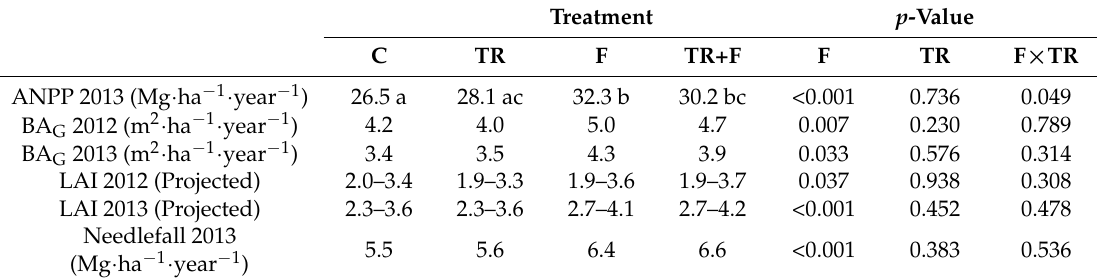
Table 2. Mean aboveground net primary productivity (ANPP), basal area growth (BA G ), projected leaf area index (LAI), and needlefall for control (C), throughfall reduction (TR), fertilizer application (F), and throughfall reduction and fertilizer application (TR+F) treatments with associated p values. Values for LAI represent monthly minimums and maximums within a given year. For the LAI time series data, there were no treatment by month interactions. For significant F × TR interactions, significantly different ( p < 0.05) values are indicated by different small letters. Treatment p -Value C TR